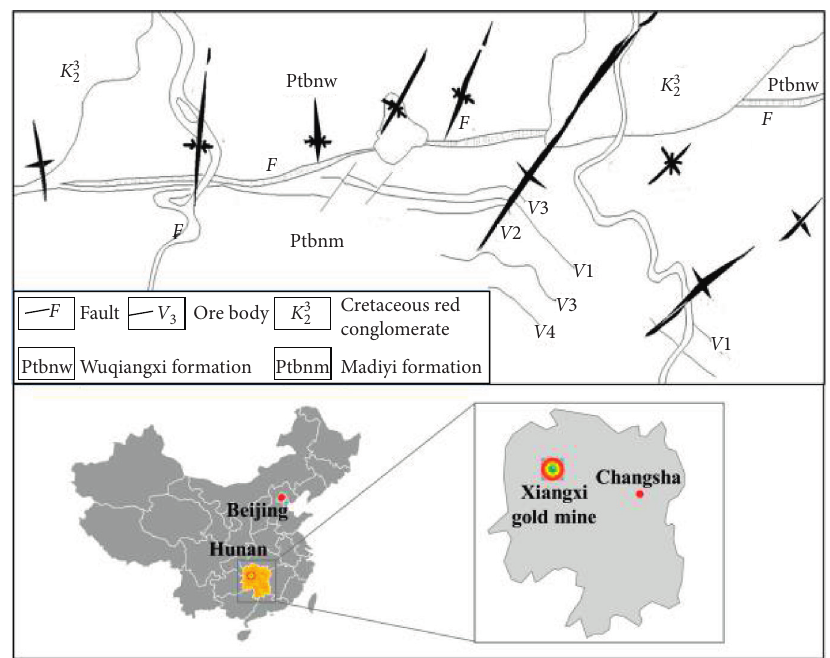
Figure 3: Schematic diagram of the structural geology of Xiangxi gold mine.